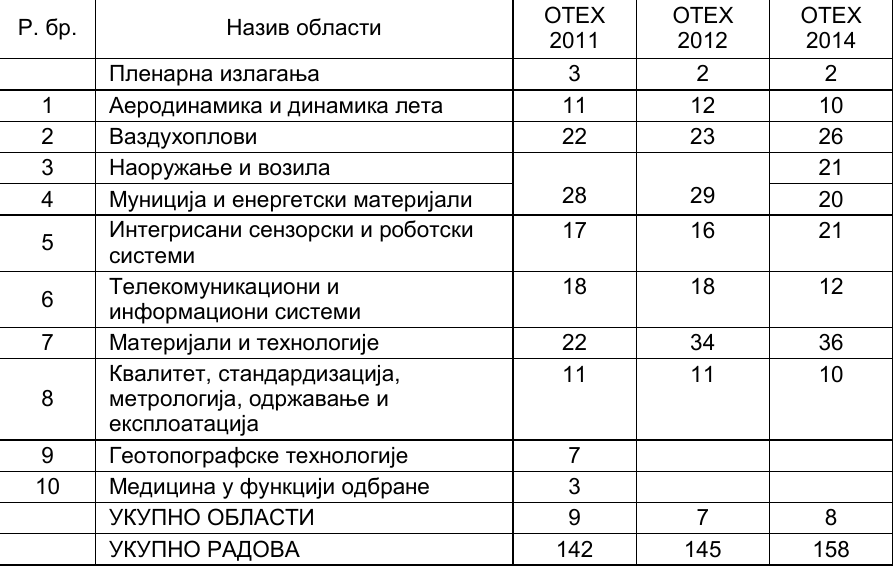
Table 1 – Overview of the number of all papers grouped by Conference areas Таблица 1 – Обзор работ по по каждой из тем , представленных на конференции Р . бр